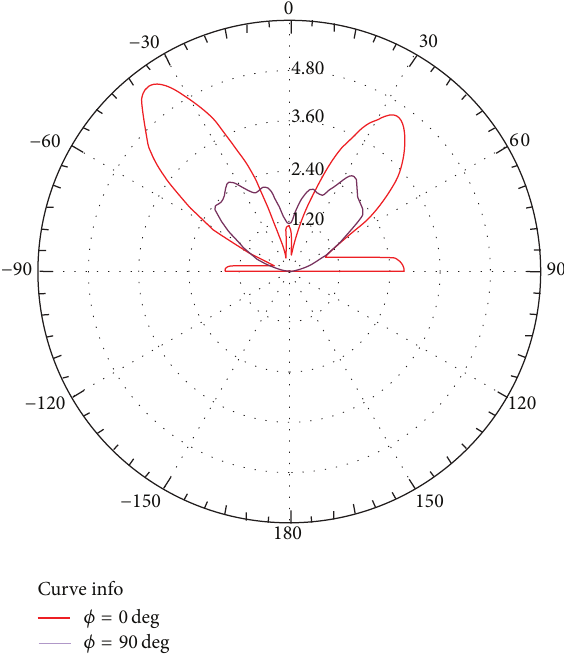
Figure 20: Directivity of the CRA for the fourth iteration at 8.44